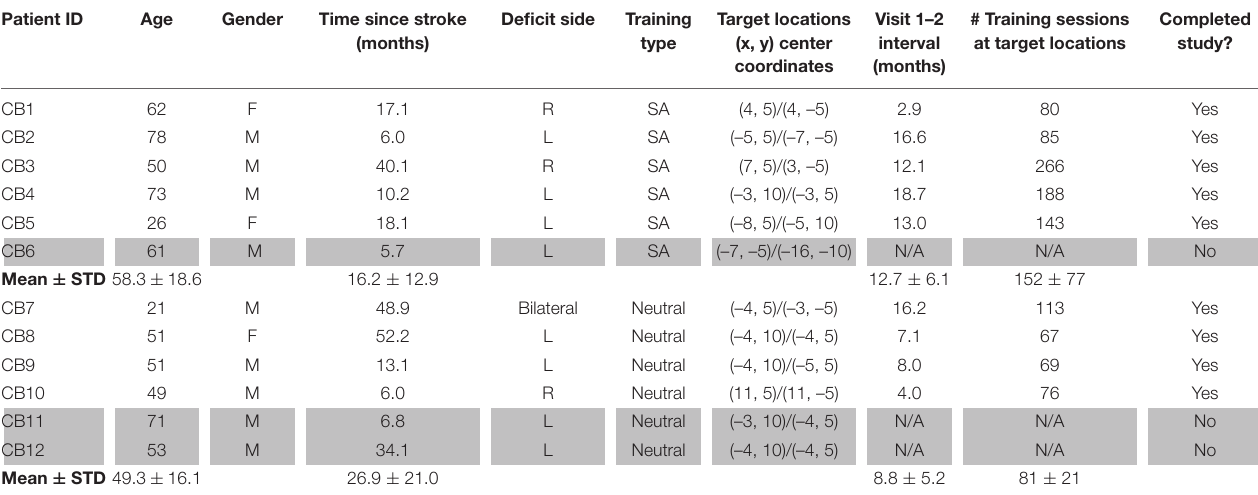
TABLE 1 | Patient demographics and training